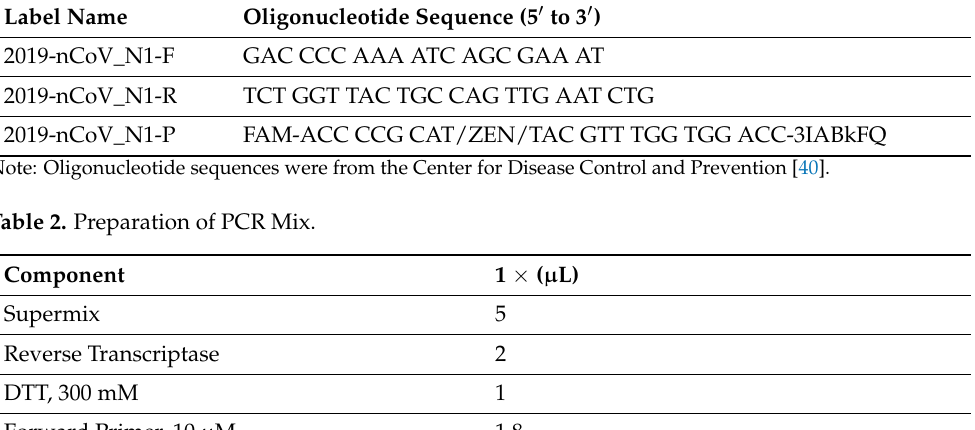
Table 1. Primers and Probe Used in ddPCR. Label Name